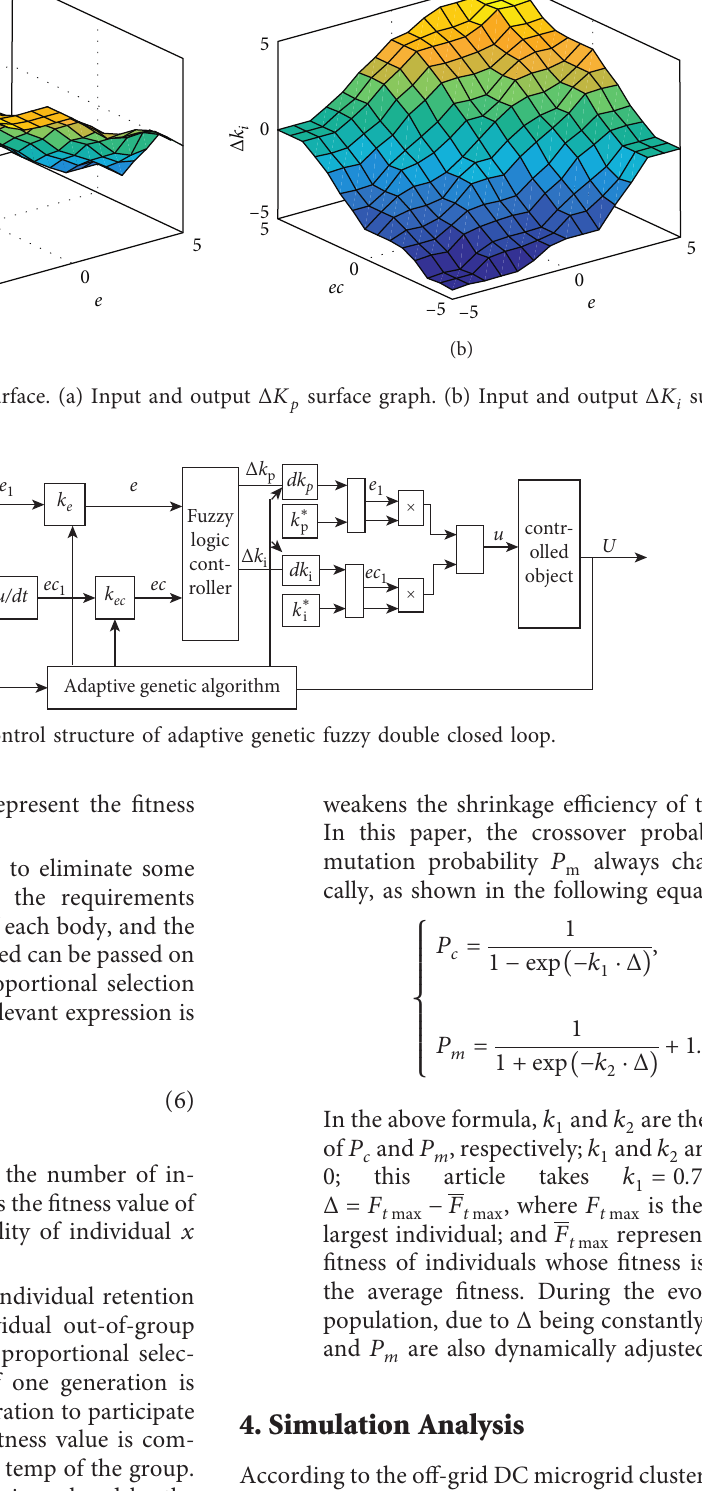
K i surface graph.